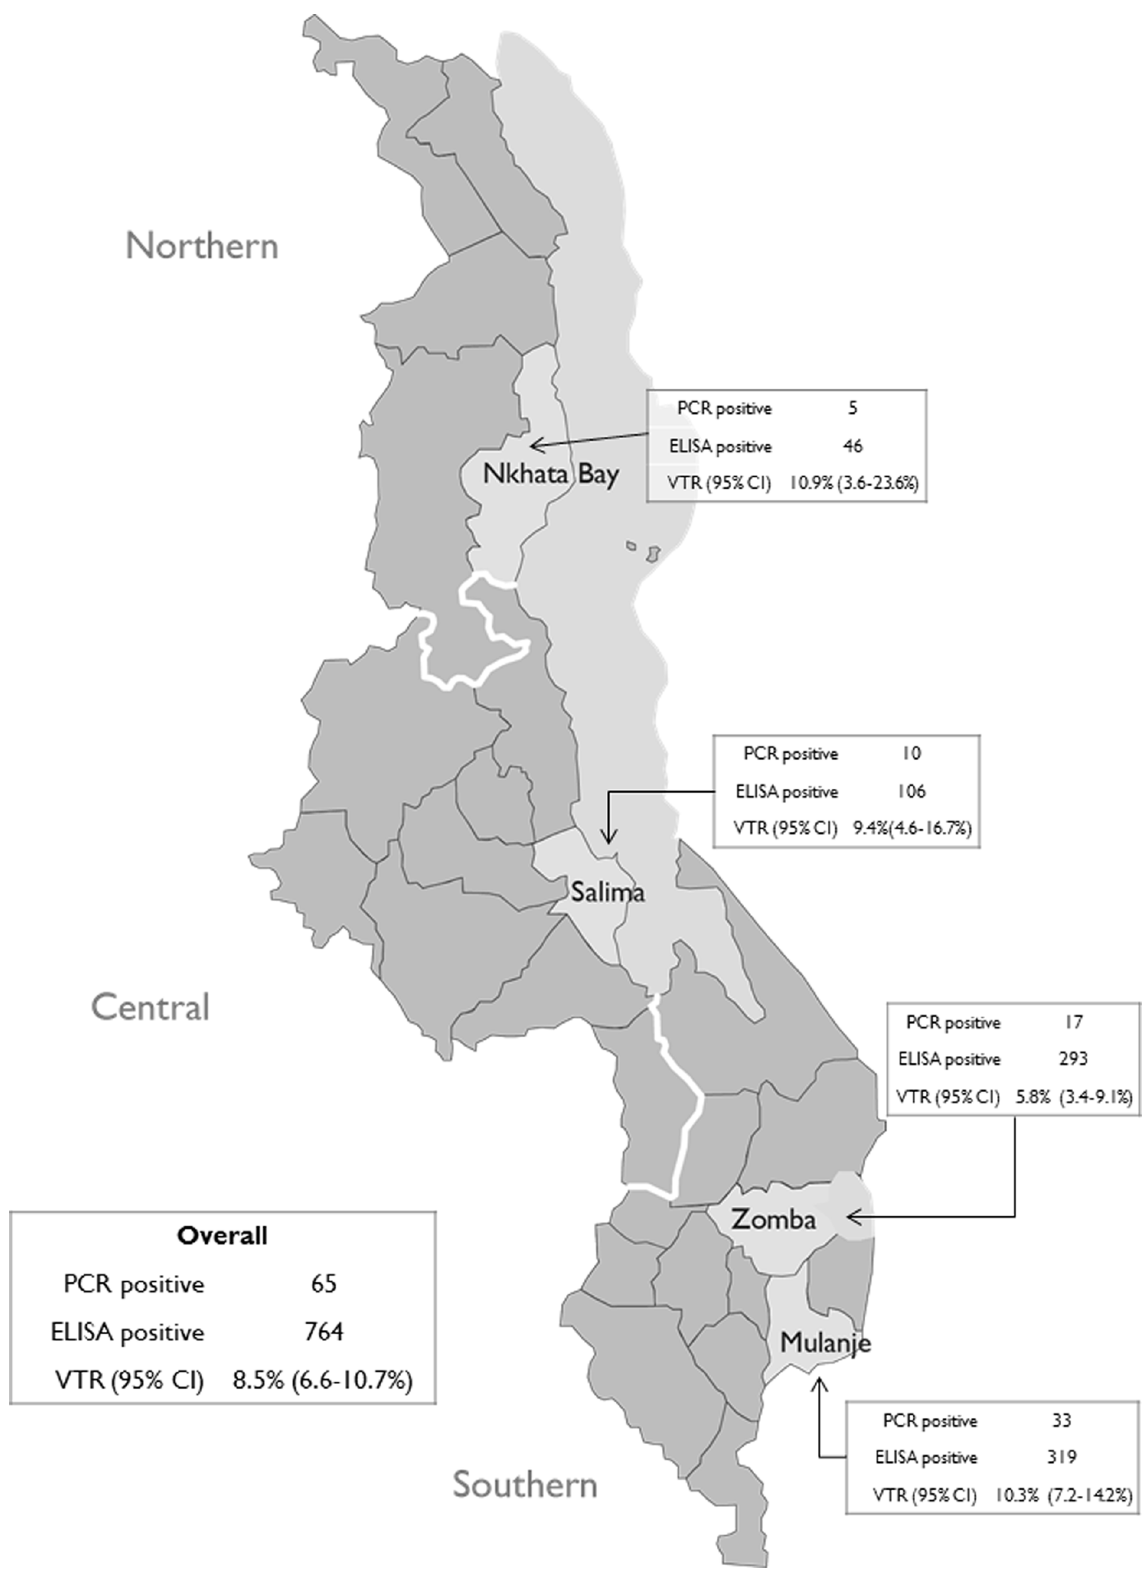
Figure 1. Transmission Rates Overall and by District.